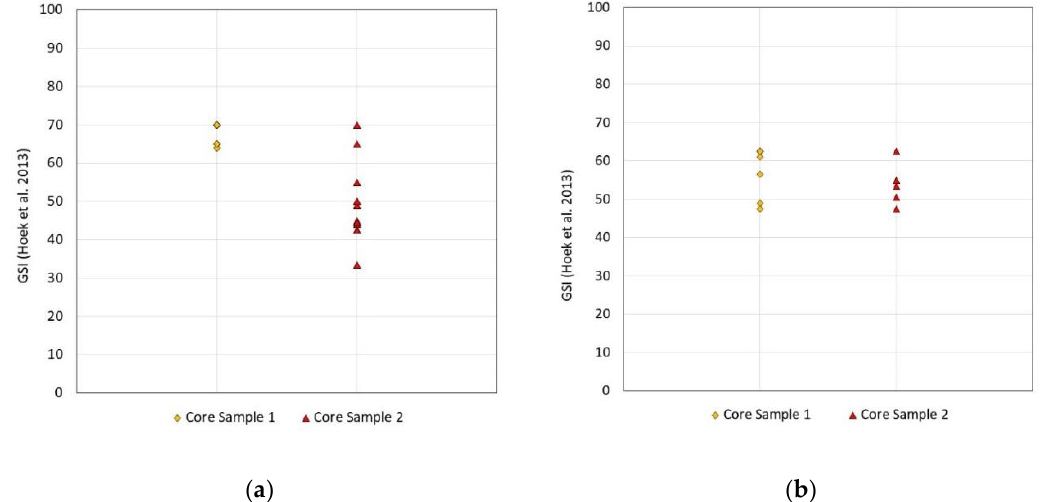
Figure 5. GSI values calculated using the [38] quantification method. ( a ) GSI estimated using the RQD values from Figure 3a and assuming JCond 89 rating of 20 (12 and 13 observation points for Sample 1 and Sample 2, respectively); ( b ) GSI estimated using the JCond 89 values from Figure 2 and assuming RQD of 50% (nine and eight observation points for Sample 1 and Sample 2, respectively).